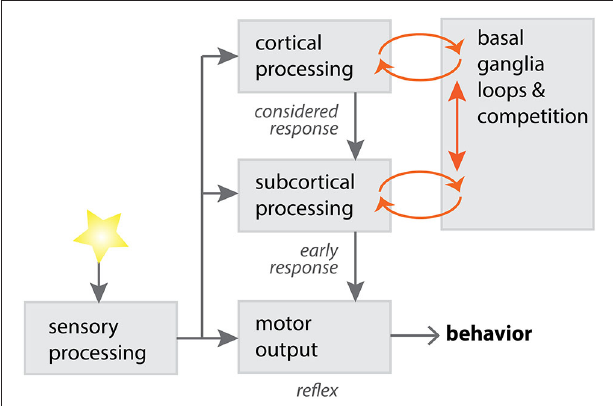
FIGURE 2 | A potential model for competition between cortical and subcortical processing, via loops through the basal ganglia . Sensory input can be processed through different channels, with varying degrees of complexity in the processing operations. Subcortical processing through the basal ganglia, using relatively primitive sensorimotor systems, is adept at providing short-latency responses to salient stimuli (Schulz et al., 2009). Cortical processing through the basal ganglia is adept at longer-latency, more complex responses to stimuli. Cortical and subcortical requests for motor control can compete within the basal ganglia, with a “winner takes all” strategy necessary for effective behavioral selection (McHaffie et al., 2005; Redgrave et al., 2011). Diagram adapted with permission from P.